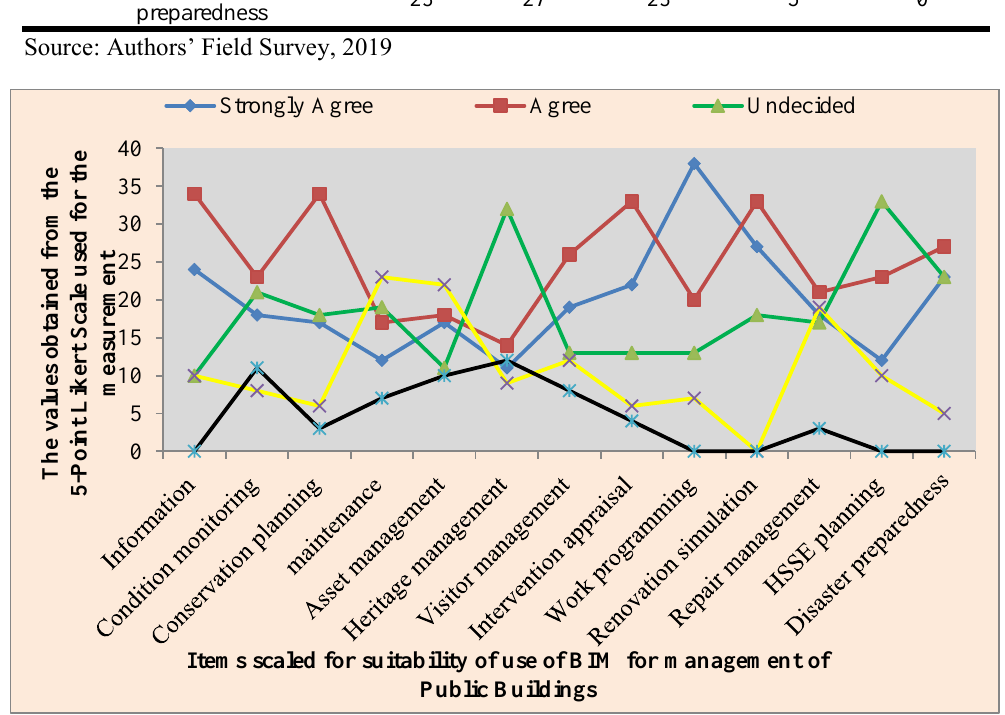
Fig. 10. 5-point Likert scale for the suitability of the use of BIM for the management of the existing building (developed by the